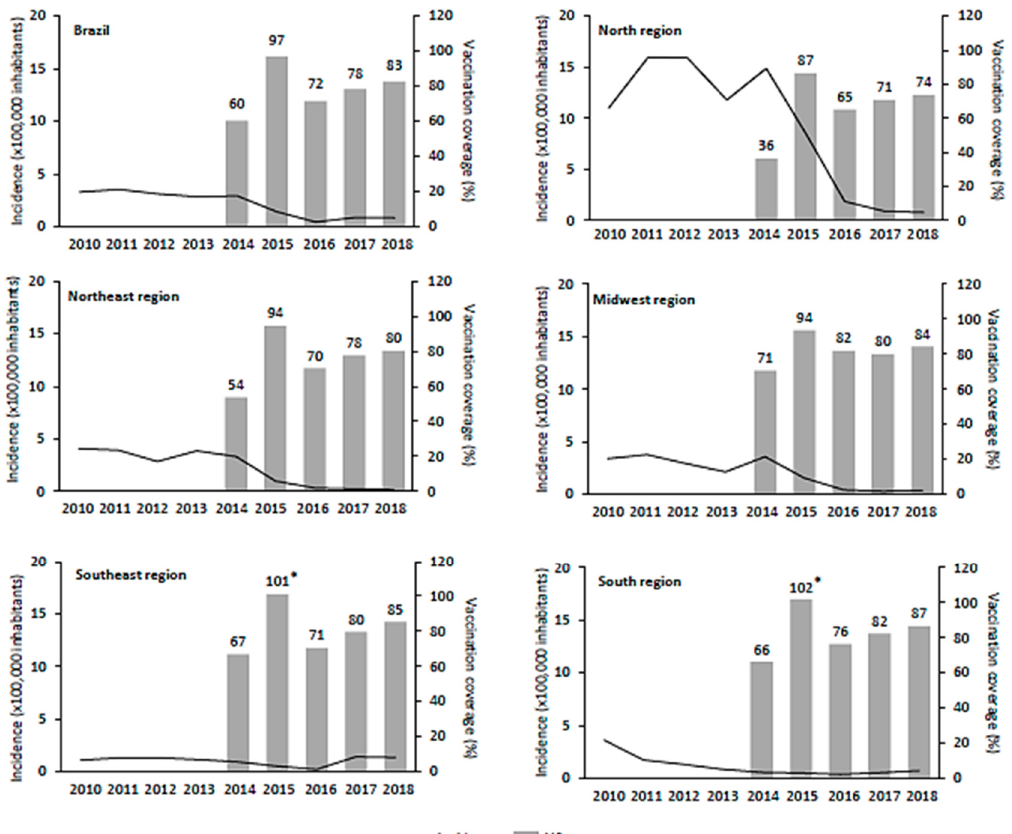
Figure 1. Incidence rate vs. vaccination coverage in different Brazilian geographic regions. * VC exceeded 100% coverage due to estimation errors in the population census.